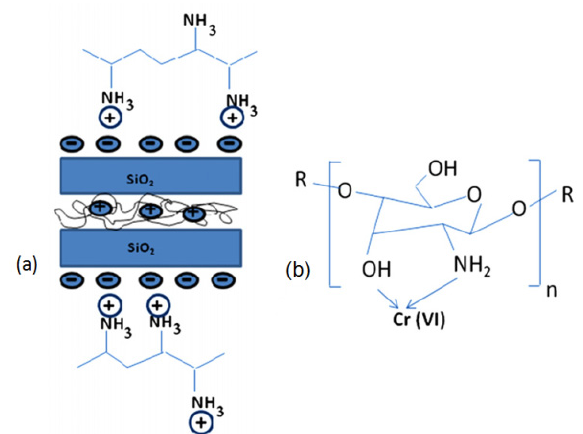
Figure 14. ( a ) Schematic structure of chitosan and clay hybrid and ( b ) mechanism of interaction of closite 10 A/chitosan nanocomposite (CCN) with Cr(VI). Reprinted with permission from [199]. Copyright 2011 Elsevier.